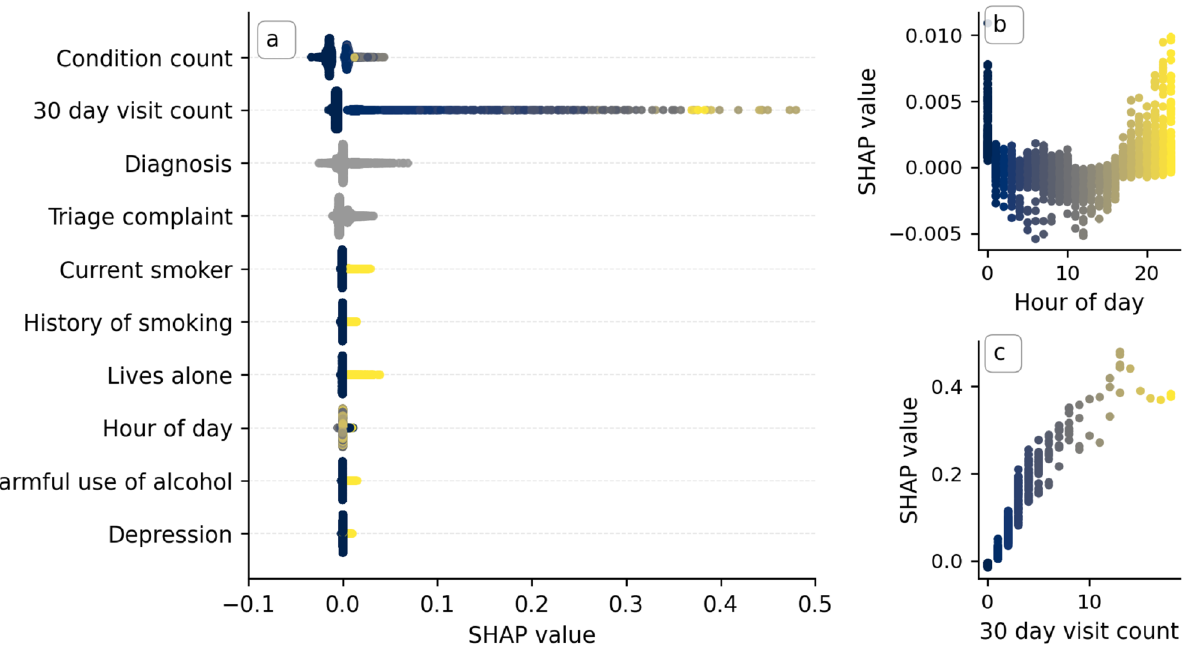
Figure 3. SHAP values for each attendance in the hold-out test set. ( a ) Plot summarizing the SHAP values for the ten most important variables (by mean absolute SHAP value) for each attendance in the test set. They are ordered by the global impact the feature has on the explanation (equal to the mean absolute SHAP value of the feature across all attendances). For the binary variables (i.e., the condition indicators) this favours variables with a high number of occurrences (i.e., more common conditions), not necessarily those associated with the high reattendance risk. ( b ) SHAP value against recorded hour of day of attendance registration (dots). ( c ) SHAP value against number of emergency department visits in the 30 days prior to the given attendance (dots). In panels ( b ) and ( c ) vertical dispersion is the result of interaction with other variables. All panels are coloured by the magnitude of the respective variable for the given data point, with lighter colours indicating higher values (e.g., inspect panels ( b ) and ( c )). Grey data points correspond to non-binary, nominal categorical variables and therefore have no natural ordering which could be used to colour the data points.